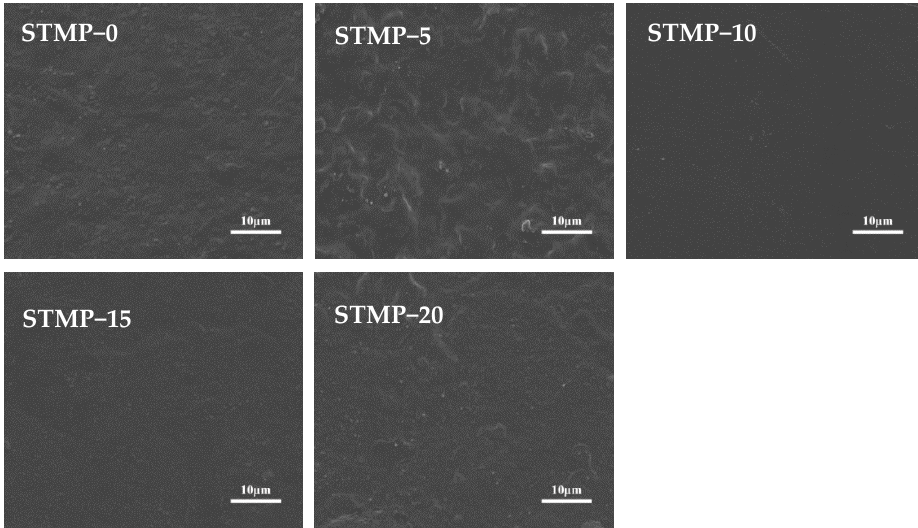
Figure 6. Scanning electron microscopy ( SEM) images of STMP crosslinked hemicellulose films.